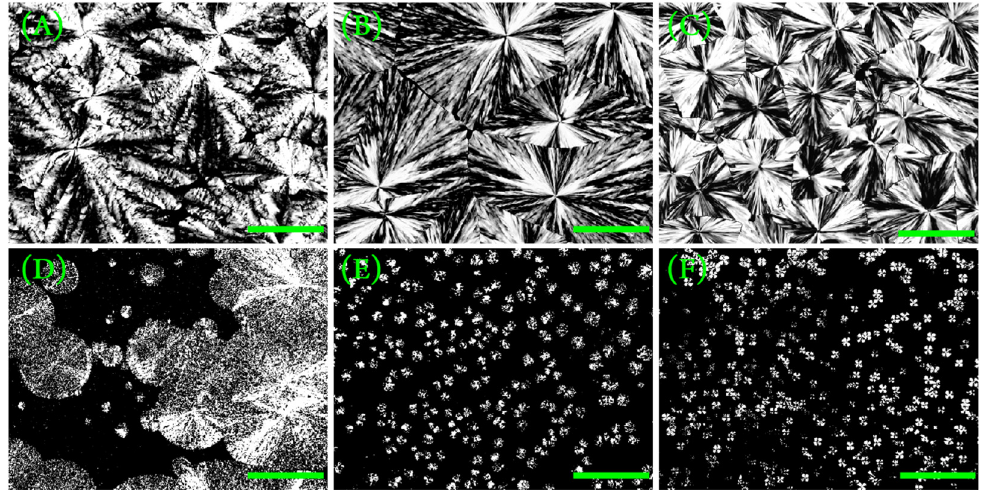
Figure 6. POM images of PBS-OH and PBS-UPy samples isothermally crystallized at 85 ◦ C. ( A ) PBS- OH-1.0k, ( B ) PBS-OH-2.1k, ( C ) PBS-OH-4.4k, ( D ) PBS-UPy-1.1k, ( E ) PBS-UPy-2.6k and ( F ) PBS- UPy-4.5k. The images were captured at a suitable crystallization level to clearly show the primary nucleation density. The scale bars are all 100 µ m in